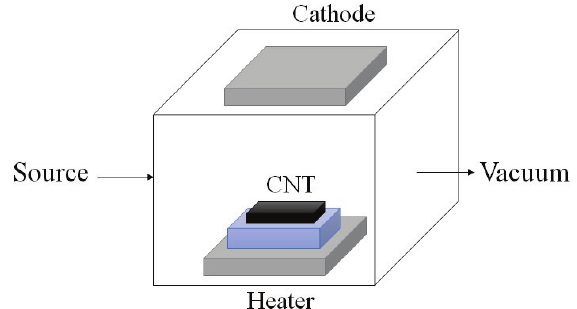
Figure 6. Schematic diagram of a PECVD technique where CNT layer is being created on the substrate in a vacuum chamber while a strong electric field generates plasma. The created field causes the nano-tube layers to grow along the electric field and perpendicular to the